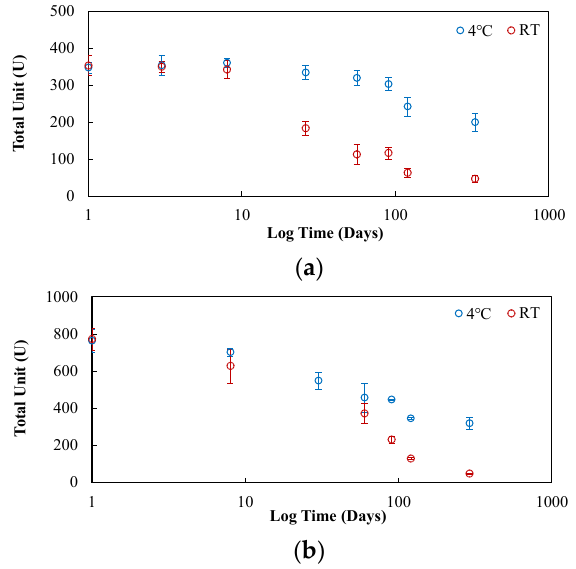
Figure 5. Urease activity measurements when stored at RT and 4 °C at different times for ( a ) Fisher Scientific and ( b ) Sigma Aldrich aqueous solutions.